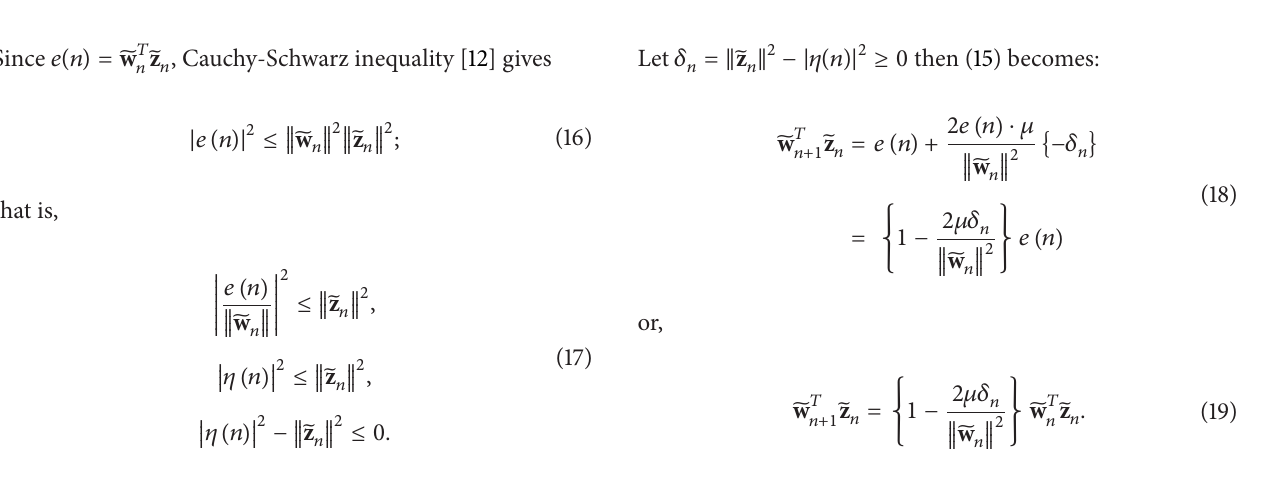
Figure 3: Learning curves of total misalignment of TLMS